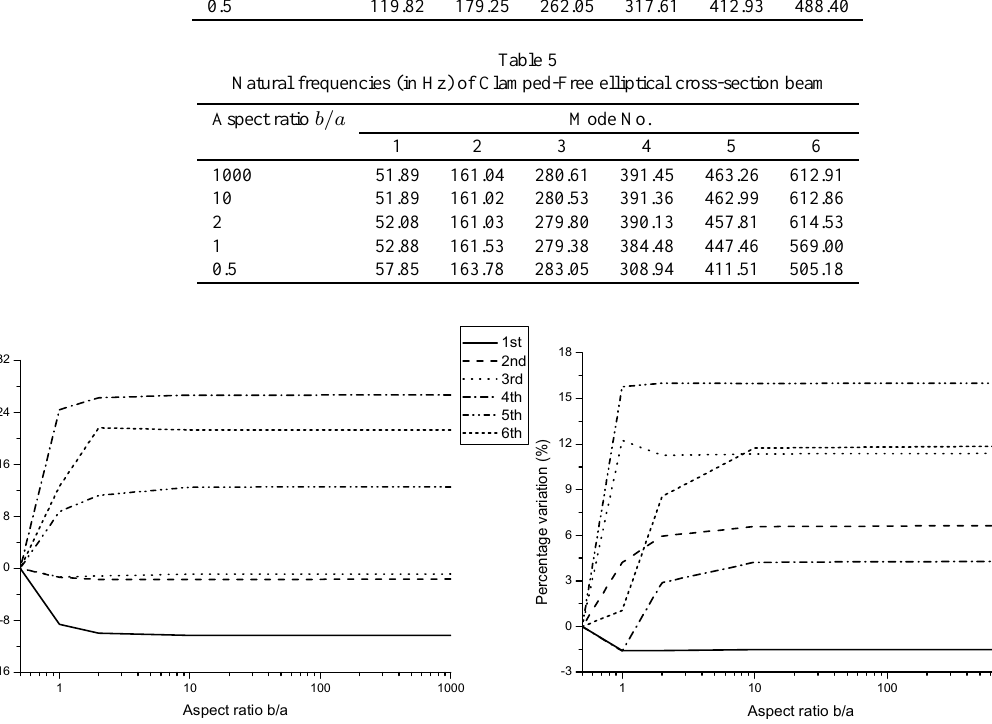
Fig. 7. Percentage variations of first six frequencies versus aspect ratio for (a) Clamped-Free and (b) Simply-Supported elliptical section